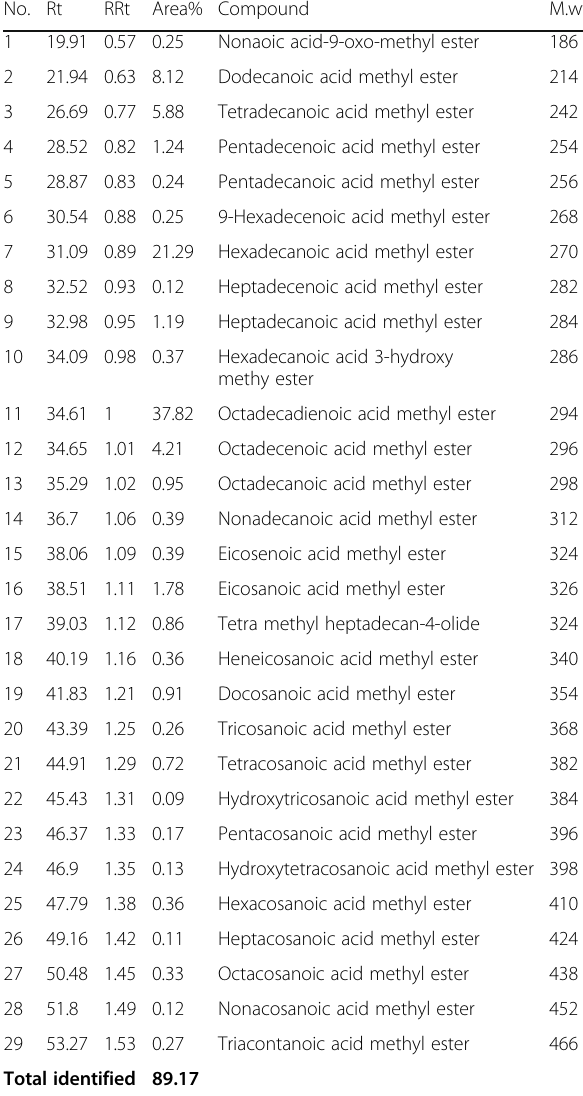
Table 8 GC/MS analysis of fatty acids methyl esters from Thevetia peruviana leaves No.